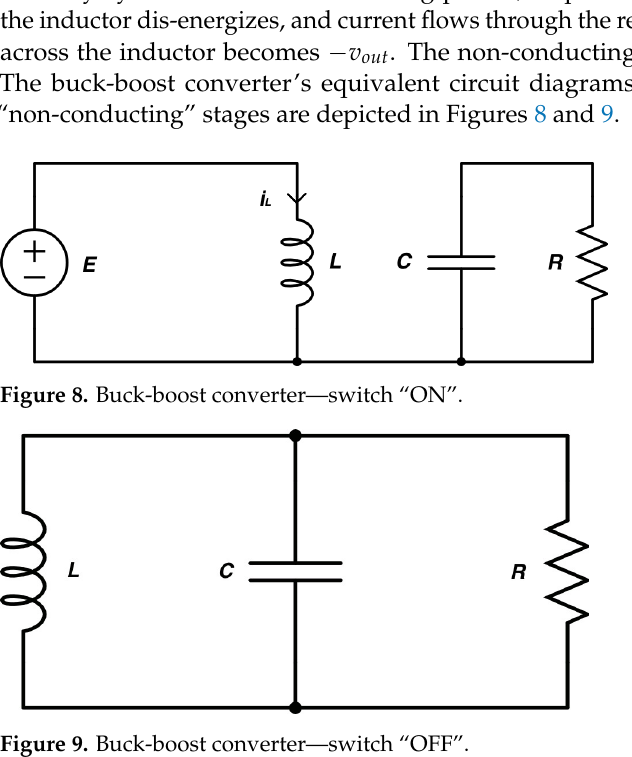
Figure 9. Buck-boost converter—switch